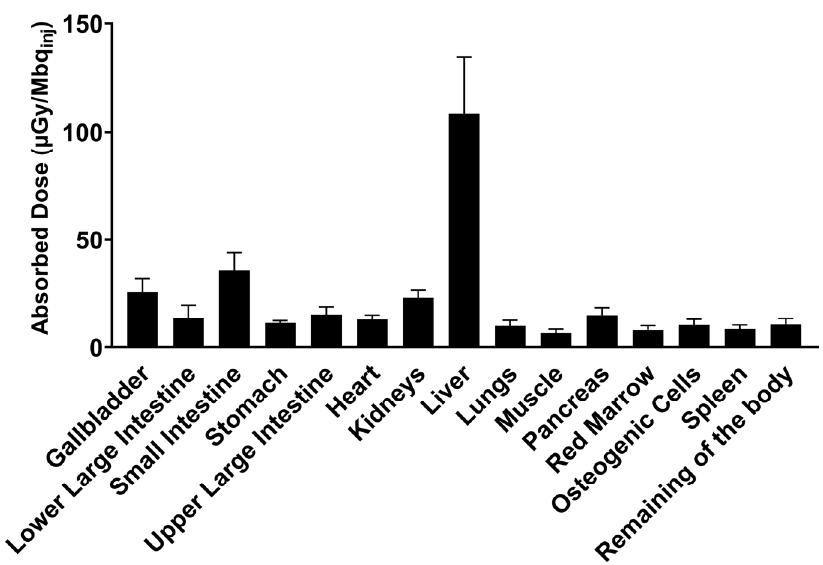
Figure 8. Human predicted dosimetry of [ 18 F]MK-7246 extrapolated from n = 2 rat biodistribution, expressed as the absorbed dose per unit of administered radioactivity ( μ Gy/Mbqinj).